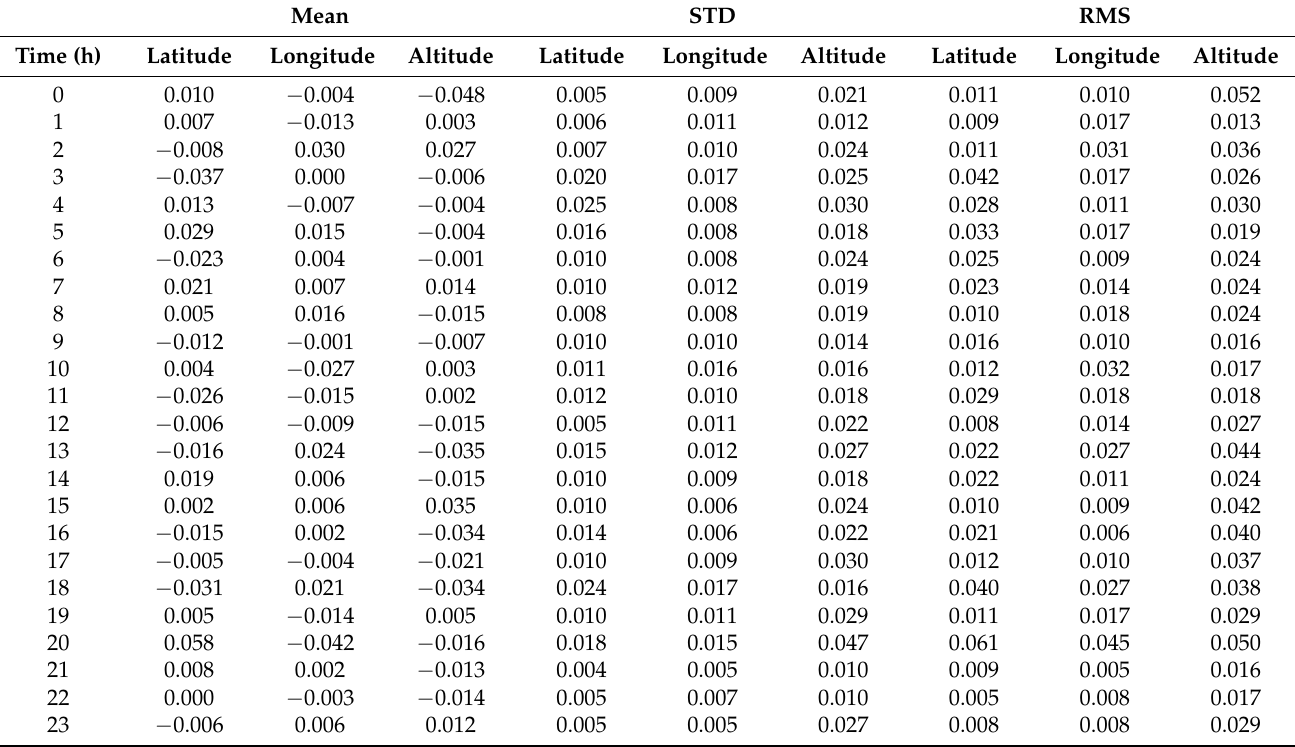
Table 2. Statistical results (expressed in metres) obtained by using